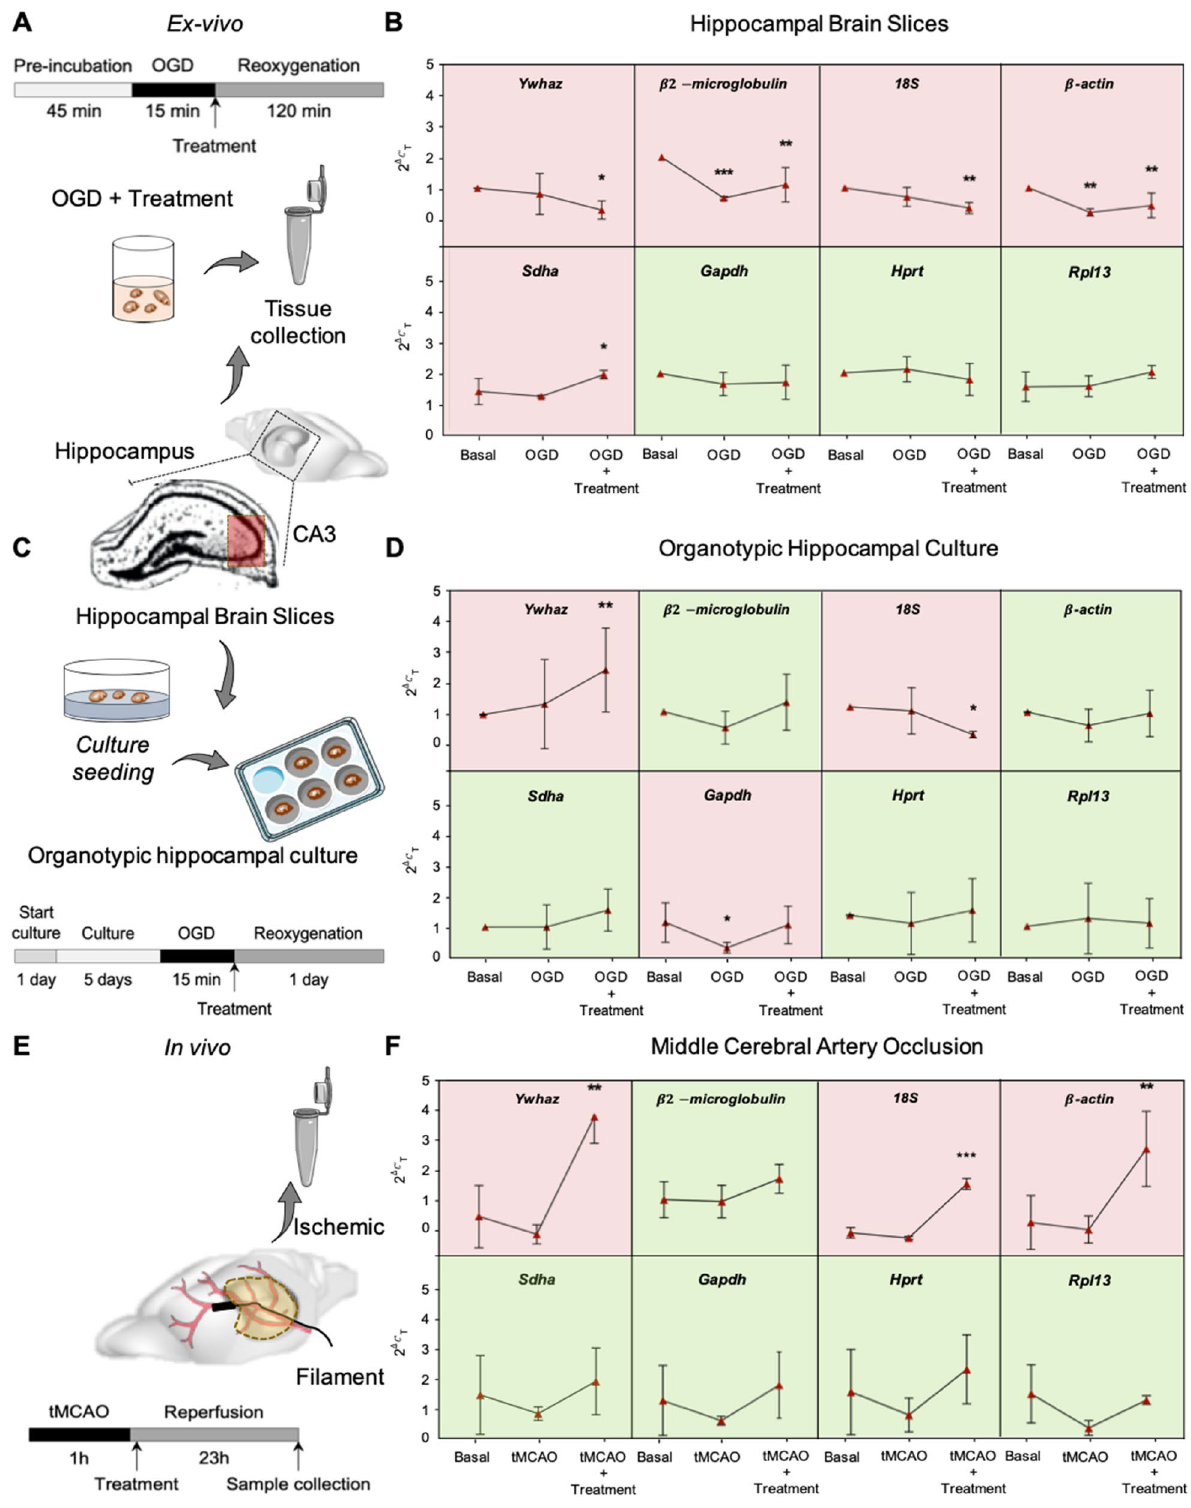
Figure 1. Experimental validation of eight housekeeping genes in three different brain ischemia models. ( A ) Rat hippocampal brain slices were stabilised for 45 min, followed by 15 min of oxygen and glucose deprivation (OGD) and 2 h of re-oxygenation (Re- Ox). ( B ) Gapdh, Hprt and Rpl13 gene expression remains stable while Ywahz, 18S and Sdha are significantly up-or down-regulated after pharmacological intervention. β2-microglobulin and β-actin showed instability in all hypoxic conditions ( *p < 0.05, **p < 0.01, ***p < 0.001, n = 5). ( C ) After 5 days of culture stabilisation, organotypic hippocampal cultures (OHCs) were exposed to 15 min of OGD followed by 24 h of Re-Ox. ( D ) While β2-microglobulin, β-actin, Sdha, Hprt and Rpl13 expression remains stable under all experimental conditions, Ywhaz, Gapdh and 18S resulted in unsuitable housekeeping genes for this model ( *p < 0.05, **p < 0.01, n = 5). ( E ) Adult WT mice were subjected to a 1 h-transient occlusion of the middle cerebral artery (tMCAO) followed by 23 h of reperfusion. ( F ) β2-microglobulin, Sdha, Gapdh, Hprt and Rpl13 gene expression remained stable under all interventions while Ywhaz, 18S and β-actin are significantly up-regulated due to treatment ( *p < 0.05, **p < 0.01, ***p < 0.001, n =